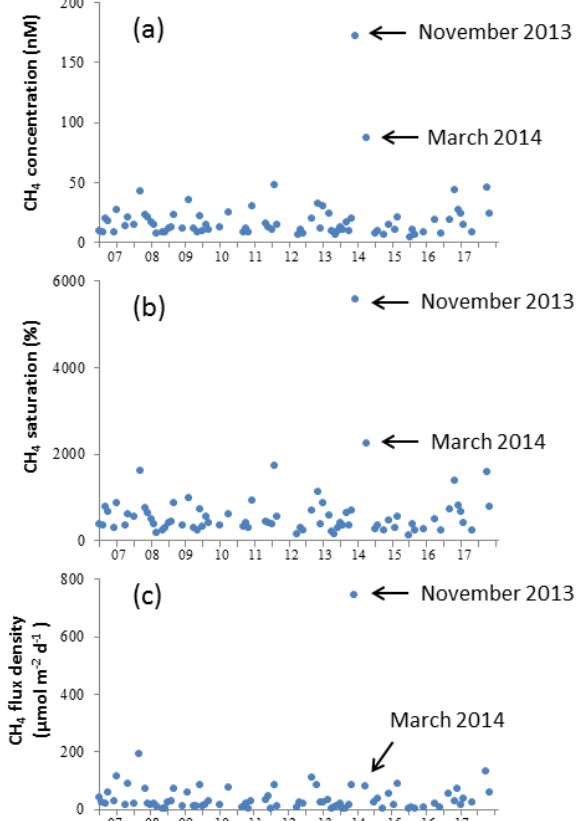
Figure 6. Inter-annual variations in dissolved CH 4 concentra- tion (a) , saturation (b) and flux density (c) at BE during 2006–2017. Data collected from December 2014 are not